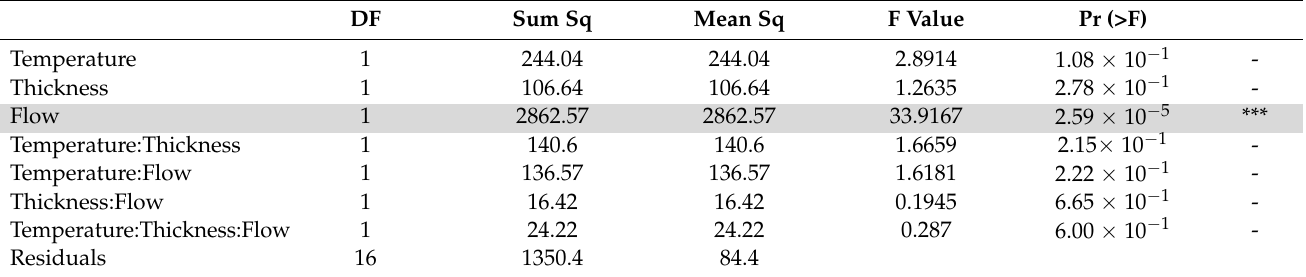
Figure 10. Flexural modulus, yield and flexural strength of the eight configurations under study. Table 13. Statistical significance of the effects of the printing parameters and their interactions on samples flexural